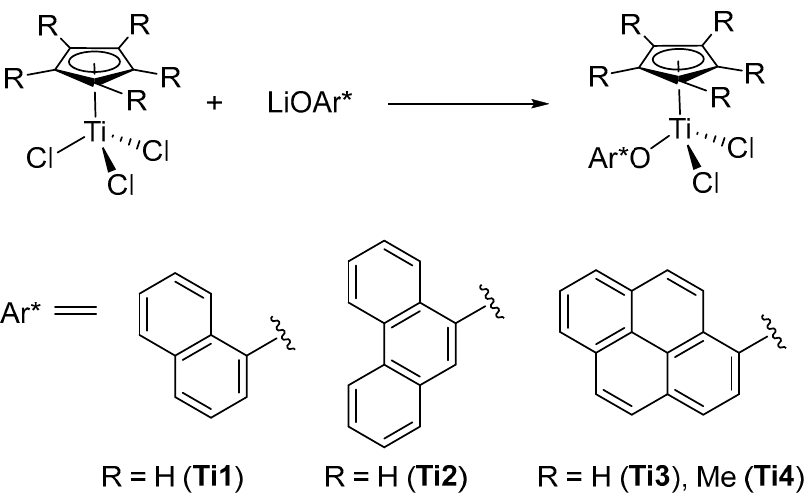
Scheme 2. Synthetic procedure for complexes Ti1 – Ti4 .